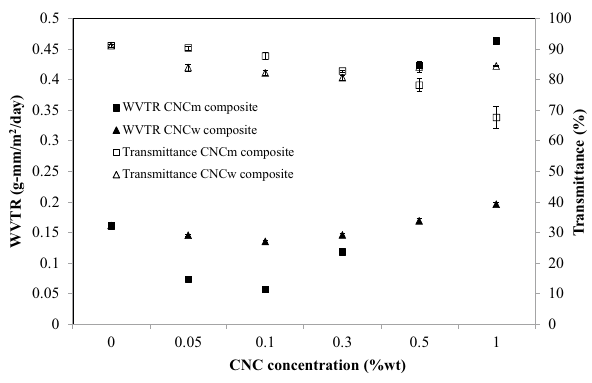
Fig. 10 Water vapor transmission rate (WVTR) and percentage vis- ible light transmittance of PU/PVDC composite films as a function of CNC